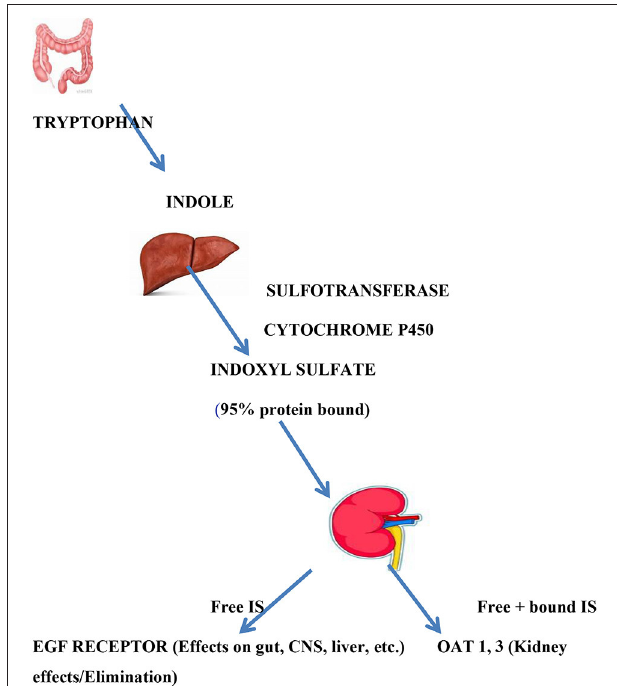
FIGURE 2 | Indoxyl sulfate production and actions. Indoxyl sulfate is the product of gut bacterial tryptophanase and hepatic hydroxylation and sulfation. It is 95% albumin bound. Renal excretion, which serves to remove bound and free IS, is mediated by OAT 1 and OAT 3 in proximal renal tubule where signaling events and elimination occur. Free (unbound) IS can act as a signaling molecule on distant tissues bearing EGF